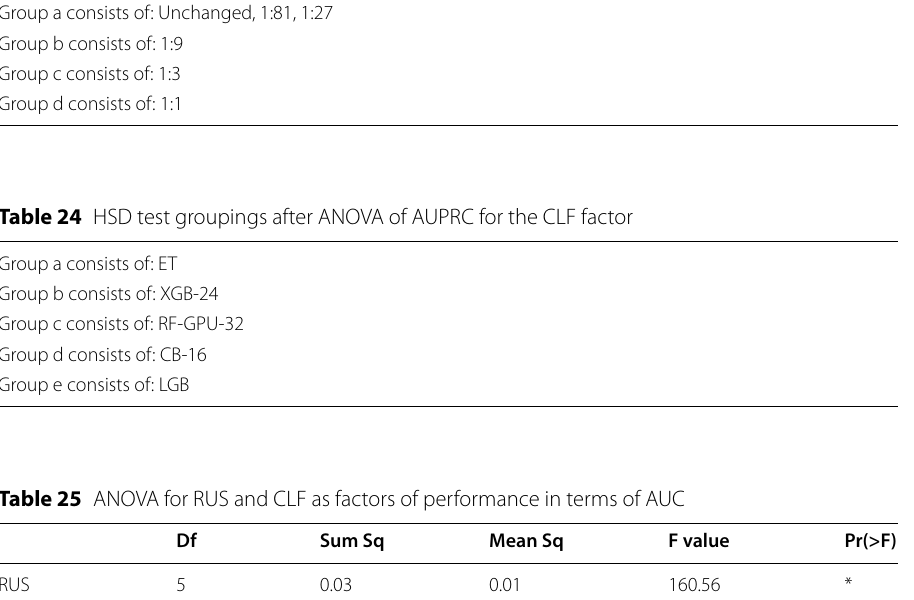
Table 25 ANOVA for RUS and CLF as factors of performance in terms of AUC Df Sum Sq RUS